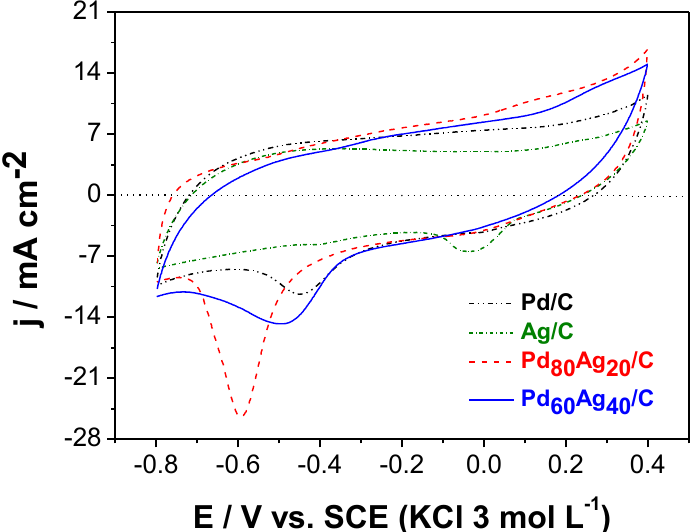
Figure 3. Cyclic voltammograms of the electrocatalysts 40% metals-based/C in N 2 -purged KOH 1.0 mol L −1 electrolyte at scan rate of 20 mV s −1 .